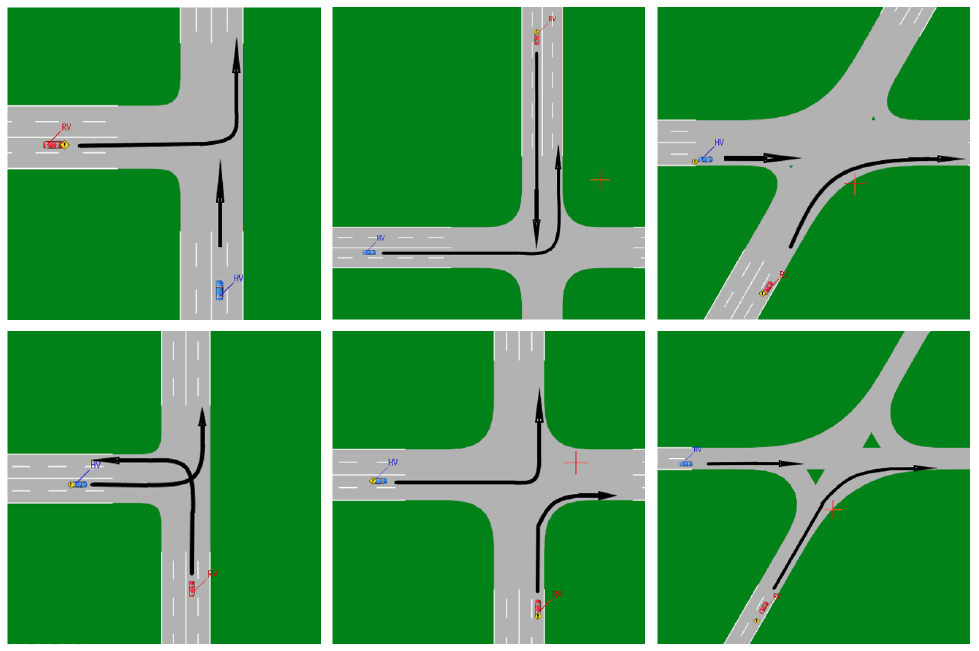
Figure 10. ICW test cases in VTD